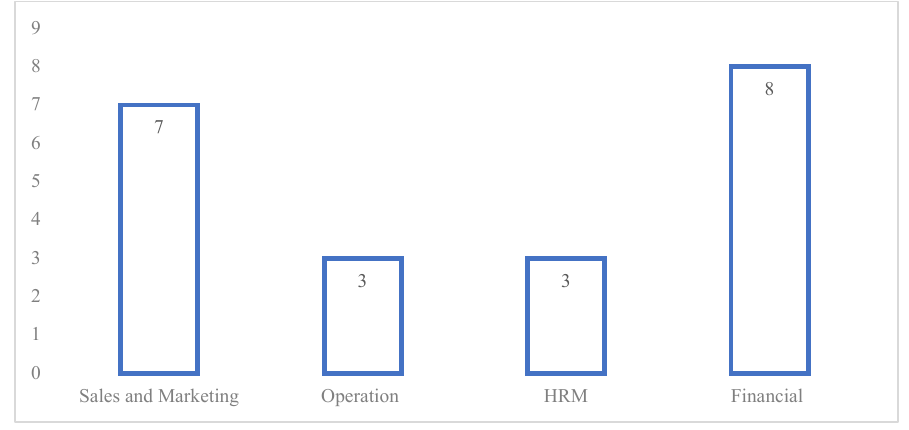
Fig. 6 Technology-related field used by SMEs